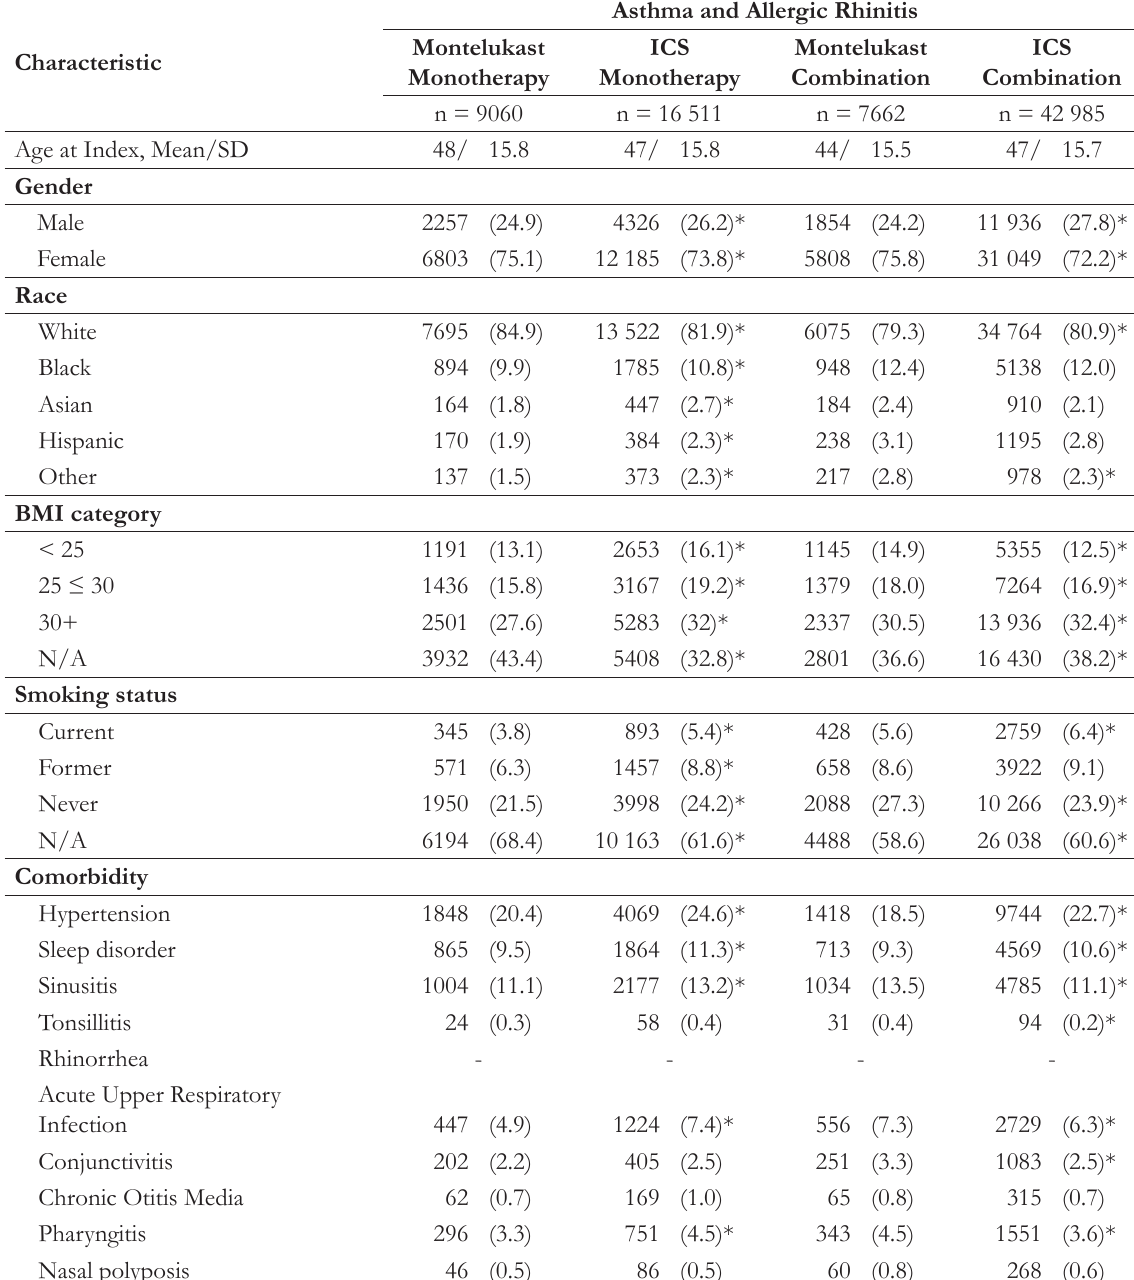
Table 1. Demographic and Clinical Characteristics of Study Patients (continued)